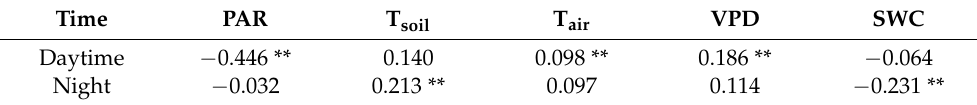
Table 2. The Pearson correlation coefficients between NEE and environmental factors.